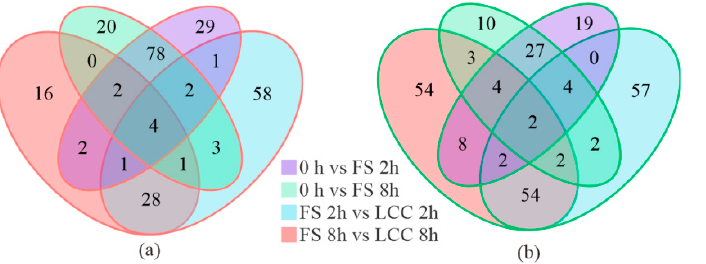
Figure 2. Venn diagram of upregulated differentially accumulated metabolites (DAMs) ( a ) and downregulated DAMs ( b ) in different comparison groups. Different color represents different groups.